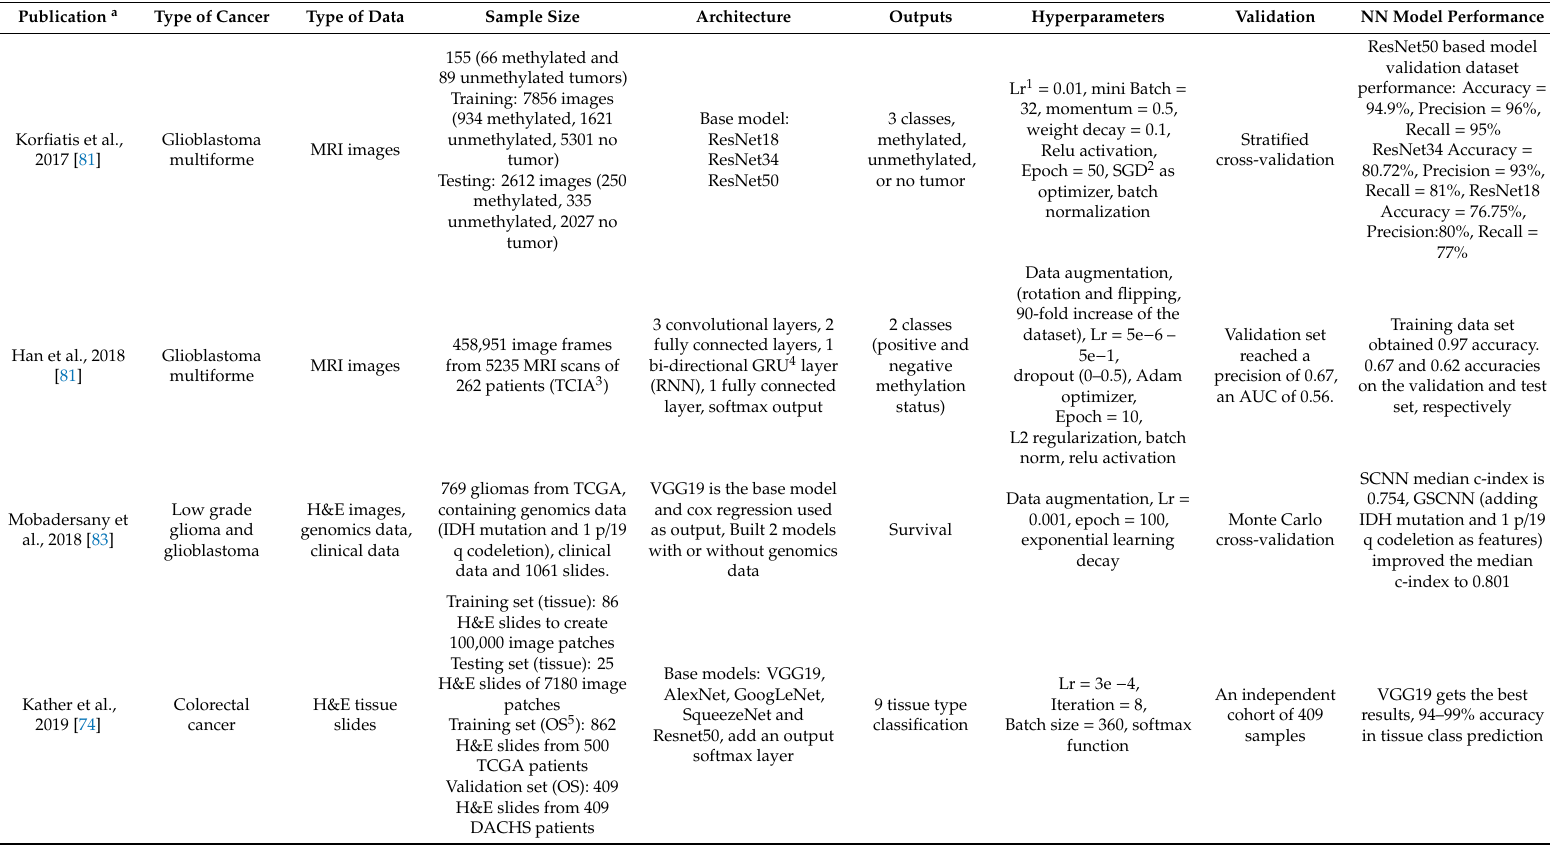
Table 3. Summary of CNN based